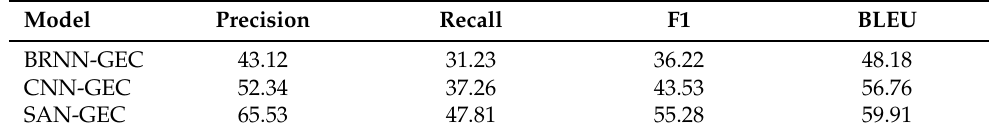
Table 3. A comparison of BRNN, CNN-GEC and SAN using precision, recall, F1 score and BLEU score.